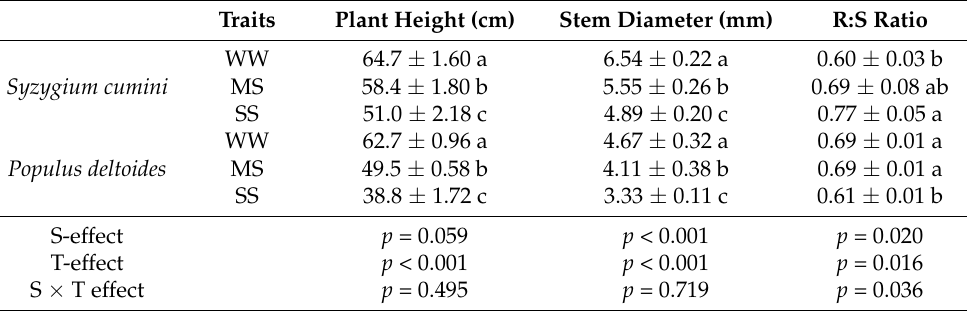
Table 1. Growth parameter plant height, stem diameter and R:S ratio under various level of water deficit treatments in Syzygium cumini and Populus deltoides . The traits were tested using a two-way ANOVA for species effect (S-effects), treatment effect (T-effects) and interaction effects (S × T). Values represent the means ( ± SE) in various treatments. Small letters represent significant difference between treatments within each species tested using the Dunnett’s test. All tests were taken to be significant at p < 0.05. Plant Height